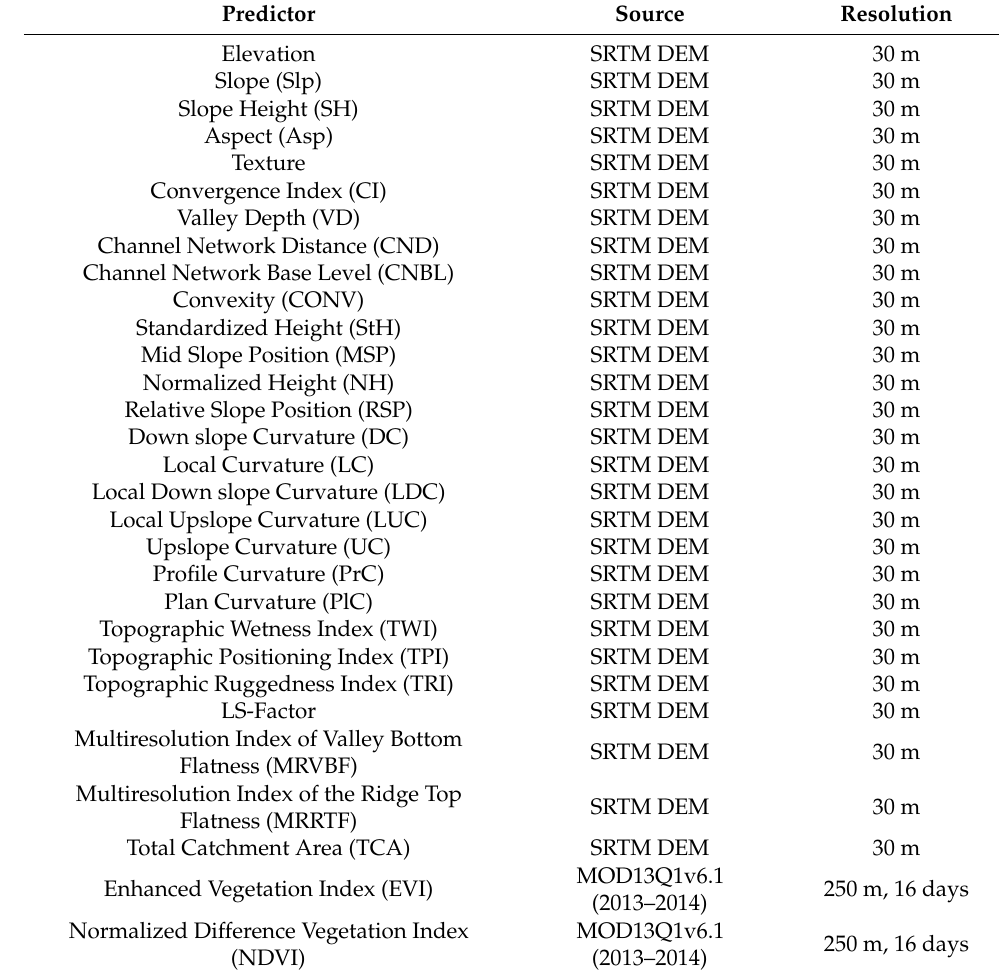
Table 1. Variety of environmental covariates included in the